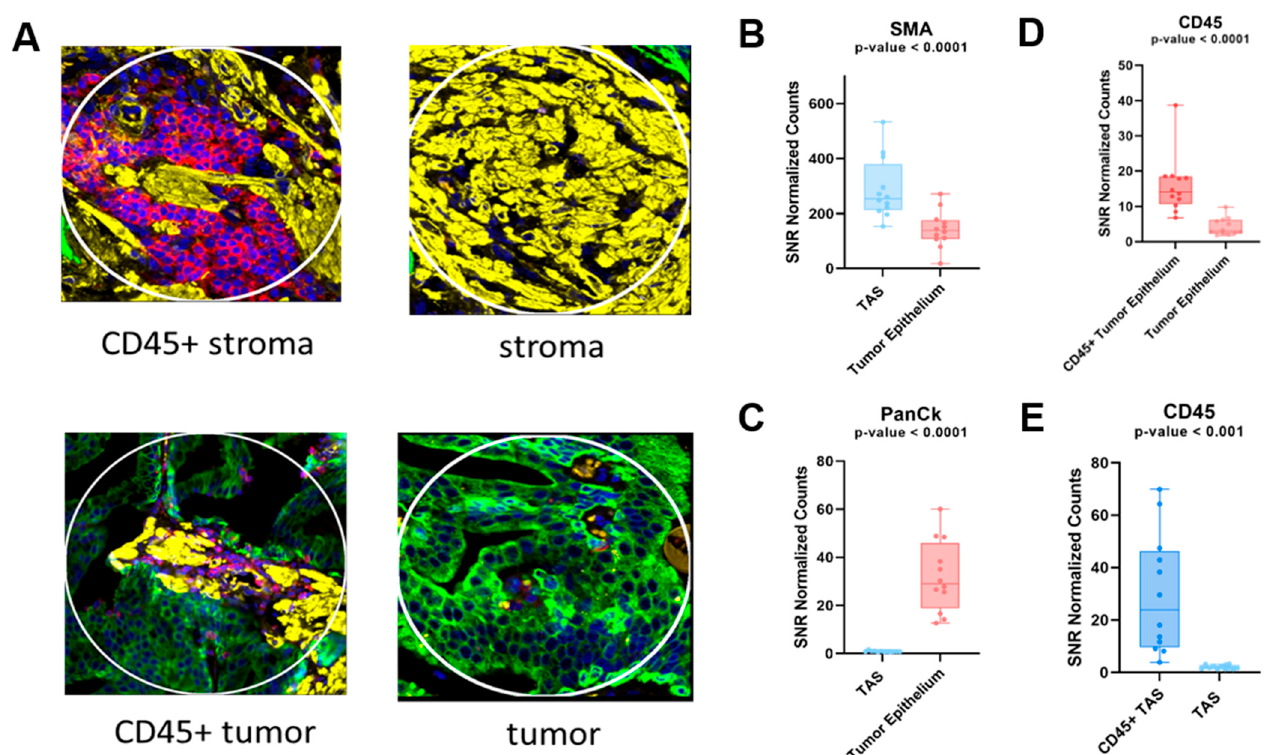
Figure 1. Immunofluorescence-stained cores for prostate cancer samples and scatter plots represent- ing protein expression of tissue markers. DSP was used to quantify expression levels for each ROI. ( A ) Representative immunofluorescence-stained cores for each tissue type. Yellow staining represents the presence of α SMA, green represents PanCk, and red represents CD45. ( B , C ) Protein expression levels of α SMA and PanCK as an indicator of stromal tissue and tumor epithelial, respectively. ( D , E ) CD45 expression differences between CD45+ tumor epithelium and tumor epithelium as well as CD45+ TAS and TAS, respectively. Each dot represents an ROI. DSP = Digital spatial profiling; ROI = region of interest; TAS = tumor-adjacent stroma.